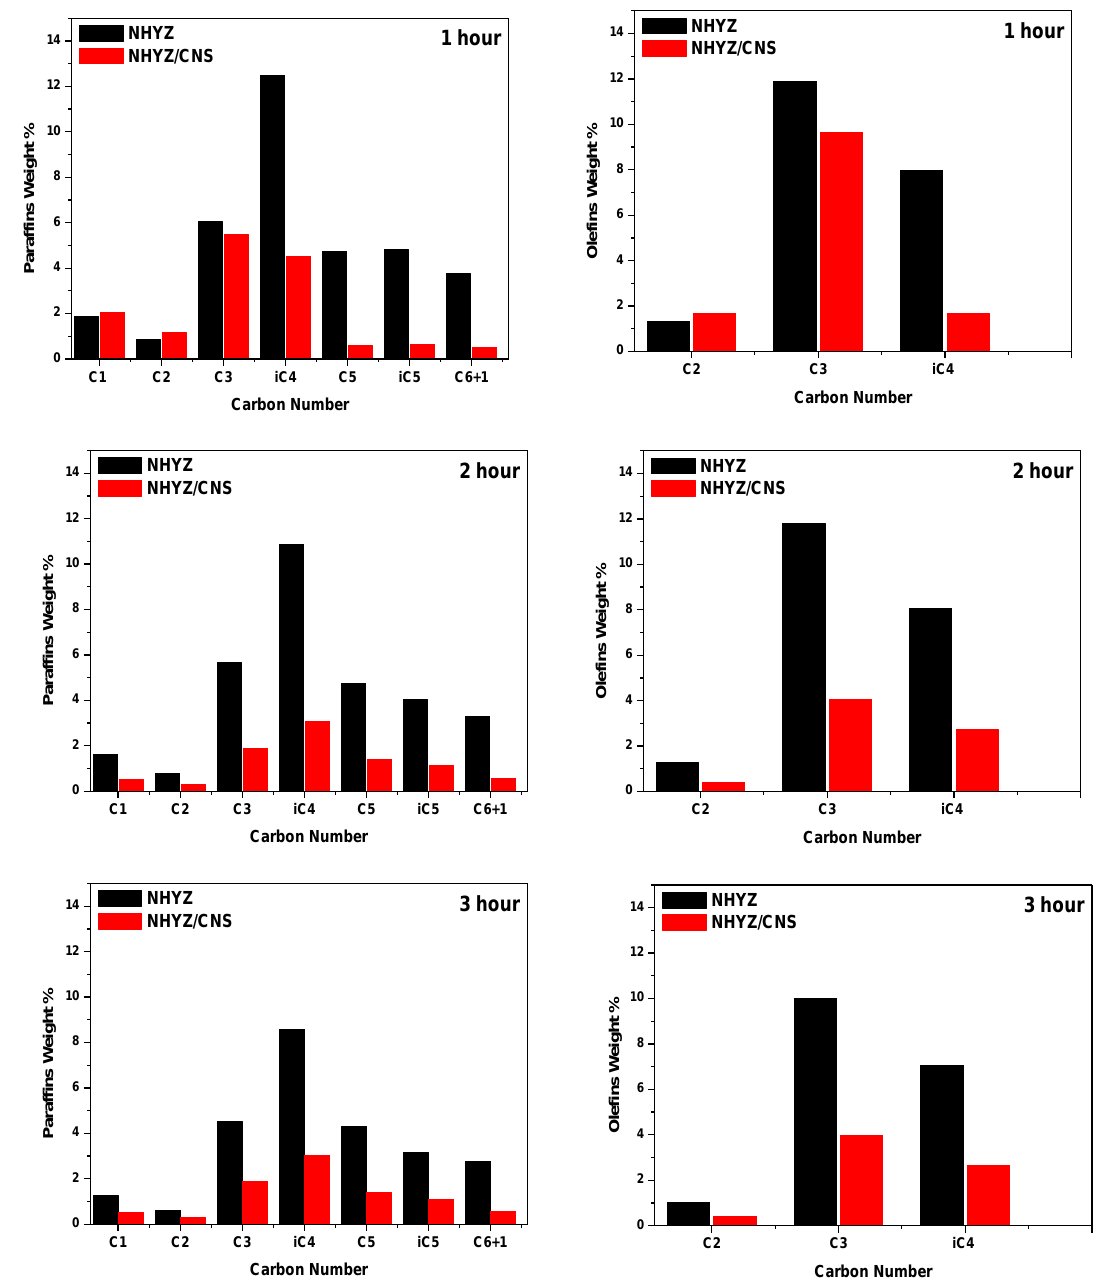
Figure 9. Paraffins and olefins carbon number in GP of NHYZ and NHYZ/CNS catalysts. Coke formation has been studied using TGA (Figure 10) of fresh and spent catalysts. Here, 3.4 and 0.8 wt.% of coke were calculated for NHYZ/CNS and NHYZ catalysts, respectively. The TGA graph of CNS alone is shown in Figure S2 and the decomposition temperature is equal to 581 °C (Table S3). Higher formation of coke for NHYZ/CNS can be explained by the overall higher conversion of the feed compared to NHYZ and the more significant hydrogen transfer process.